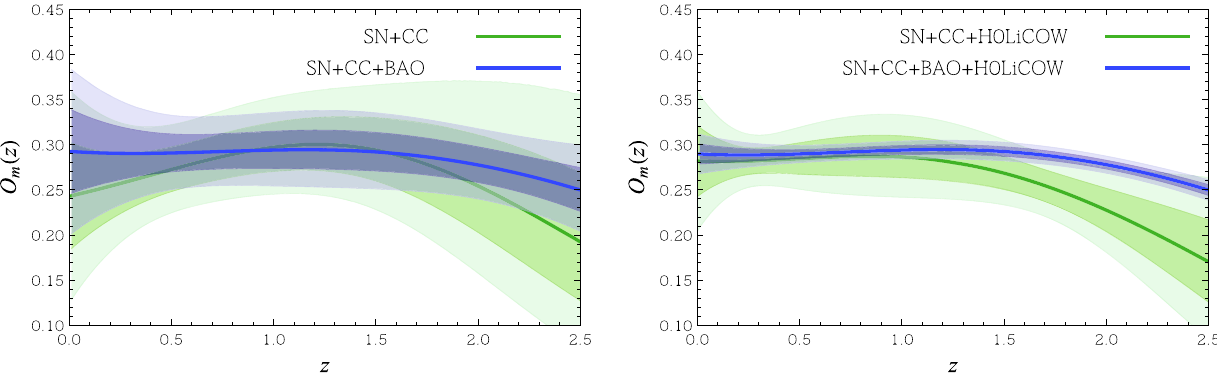
Figure9shows O m ( z ) ,reconstructedusing r d = 149 . 30 Mpc